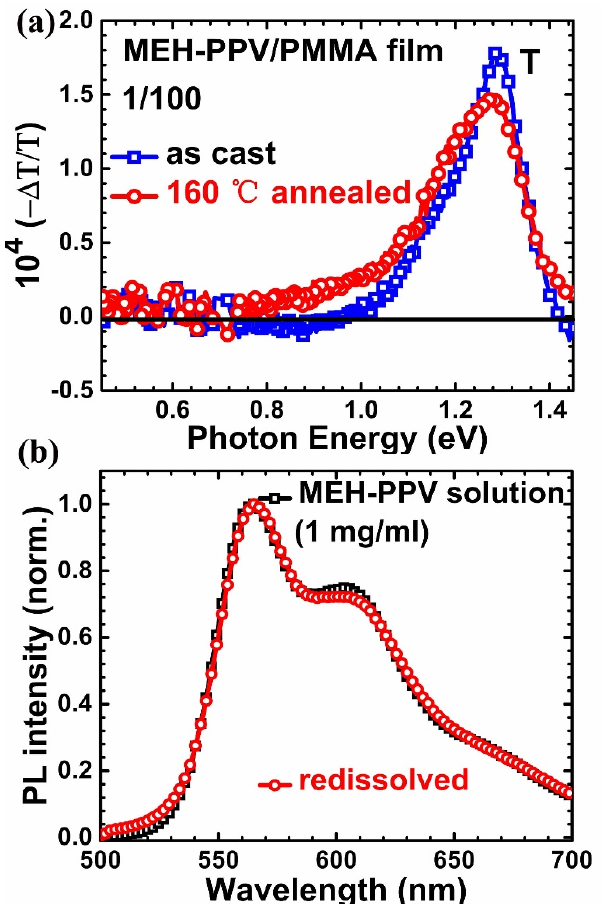
Figure 3. ( a ) Photo-induced absorption spectra of as-cast (red circle) and annealed at 160 °C (blue square) MEH-PPV/PMMA (1:100 weight ratio) blend films, respectively. ( b ) Photoluminescence spectra of MEH-PPV solution (black square) and re-dissolved solution of annealed blend film (red circle).